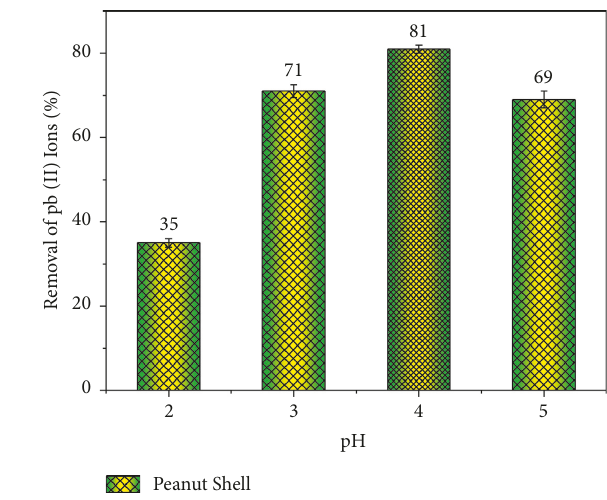
Figure 3: Effect of pH on adsorption.